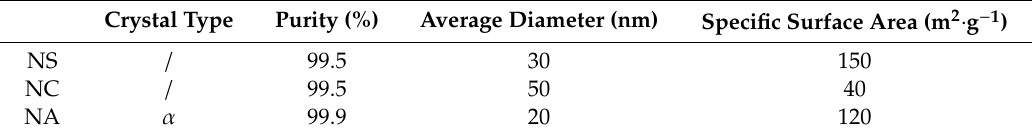
Table 3. Mix proportion of cement compound paste.